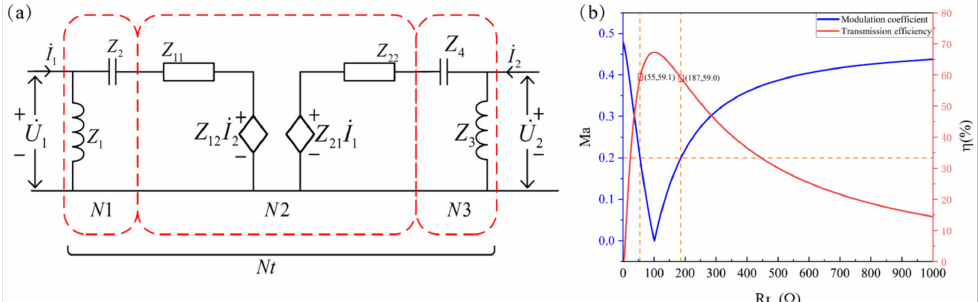
Figure 5. Trade-off design for energy transfer and reliable communication impedance modulation. ( a ) Matched channel equivalent circuit. ( b ) Modulation coefficient and transfer efficiency as the function of load